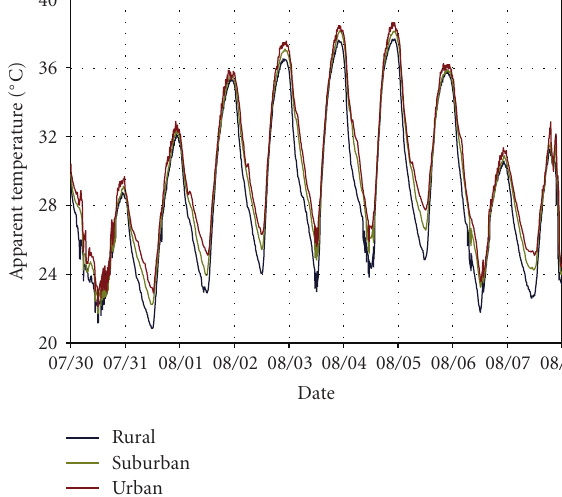
Figure 5: Composite urban (red), suburban (gold), and rural (blue) Humidex values and associated reference categories from 30 July 2008 to 8 August 2008.